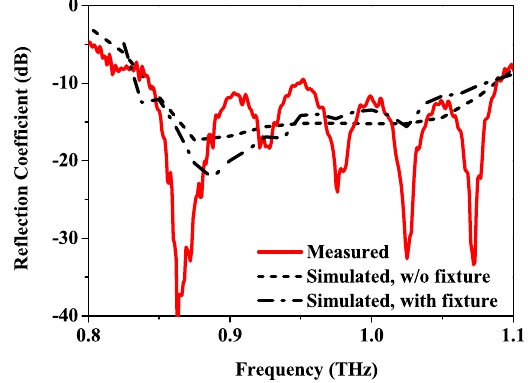
Figure 10. Measured and simulated reflection coefficient of the antenna